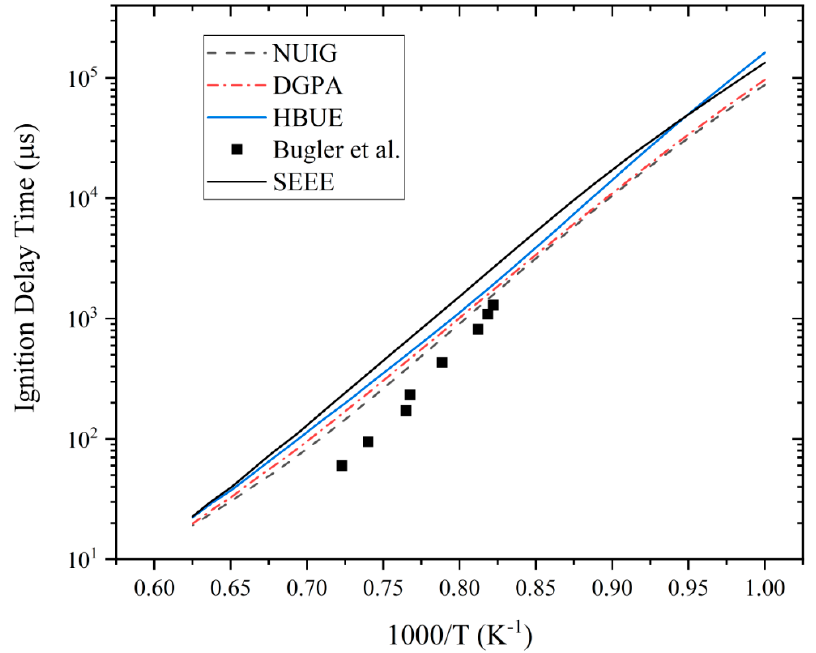
Figure 7. Comparison of the ignition delay times between NUIG, DGPA, HBUE, SEEE, and experimental data at an equivalence ratio of 0.3.